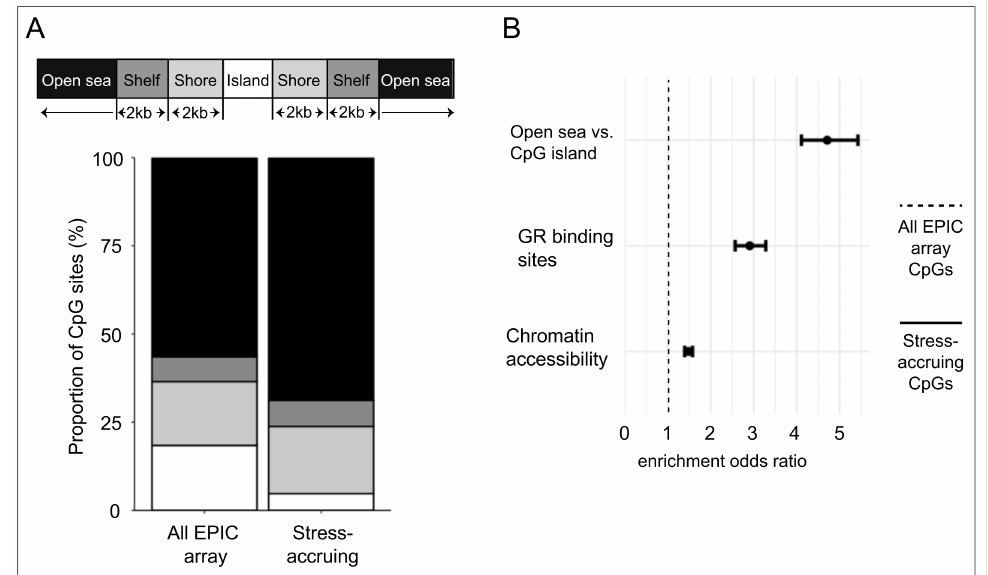
Figure 3. Cortisol-induced DNA methylation changes accrue at open sea, GR binding, and chromatin- accessible sites. ( A ). Stacked bar plot comparing the genomic region annotation of all EPIC array- covered and the stress-accruing CpG sites. ( B ). Enrichment analyses comparing the functional annotation of all EPIC array-covered CpG sites with that of the stress-accruing CpGs. Error bars show odds ratios and 95% confidence intervals, which were calculated with Fisher’s exact